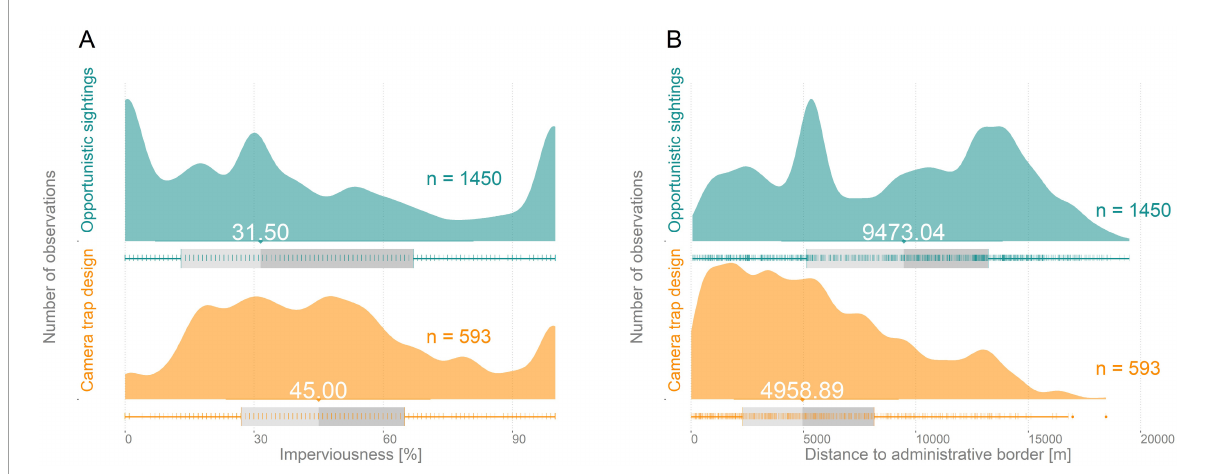
FIGURE3 Examples for differences in environmental gradients covered by the different sampling data sets. (A) Impervious surfaces. (B) Distance to administrative border (see Appendix A : Supplementary Figures 7–12 for a complete comparison of sampling locations).